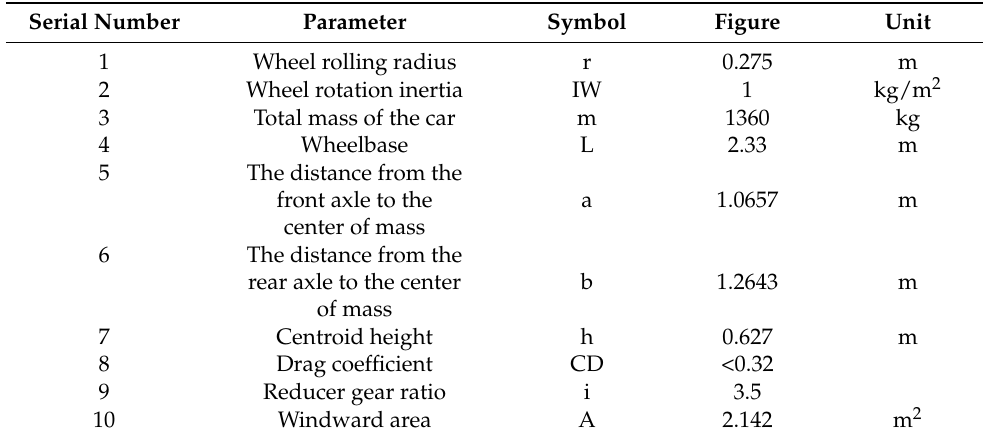
Table 1. Pure electric vehicle’s whole vehicle parameters.